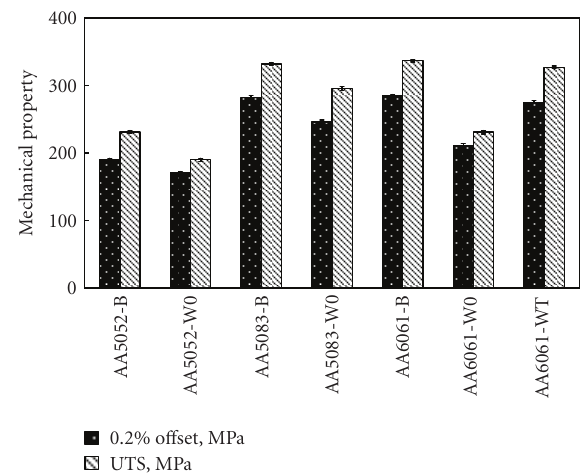
Figure 14: 0.2% proof stress and tensile strength of welded joints of AA5052, AA5083, and AA6061 alloys together with those of base metals. B: Base metal, W0: As-welded, WT: Heat treated; aged after